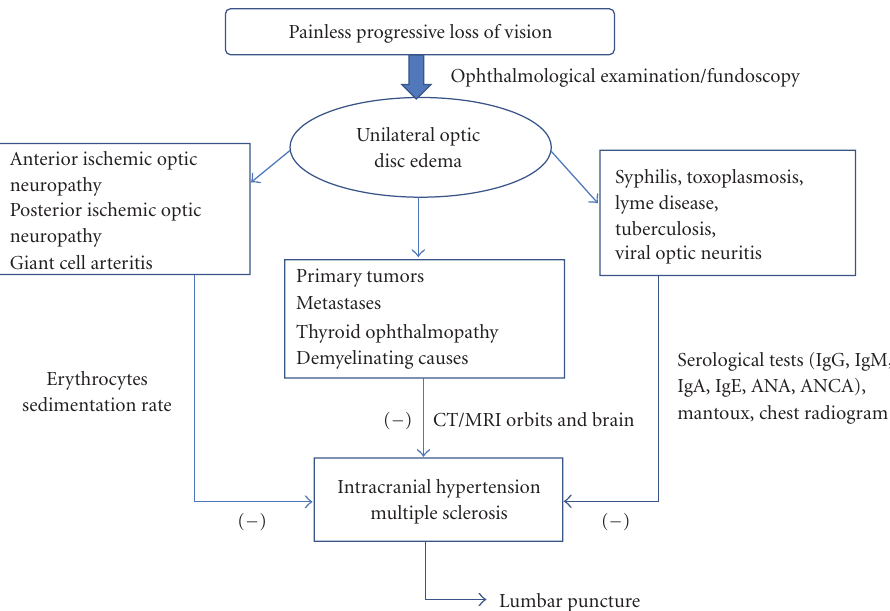
Figure 4: Di ff erential diagnosis of unilateral optic disc oedema and diagnostic